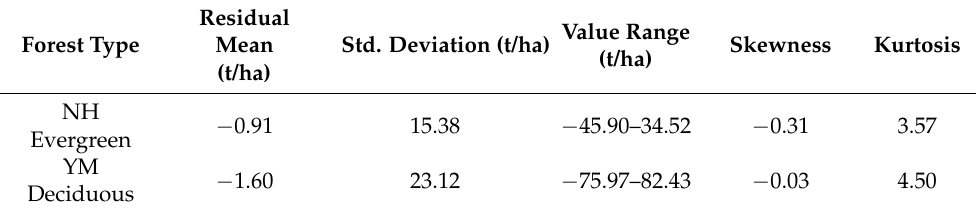
Table 6. Residual’s statistics derived from the RF model